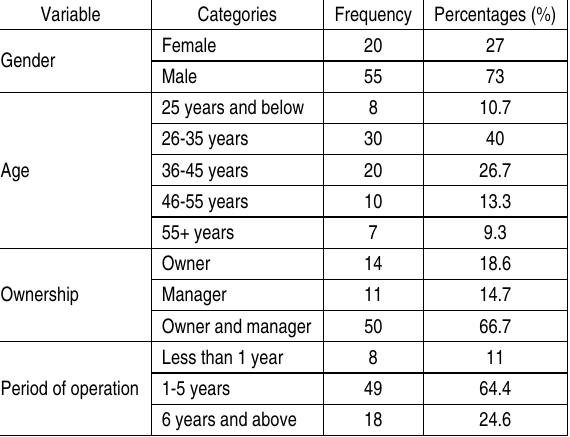
Table 2. Demographic characteristics of